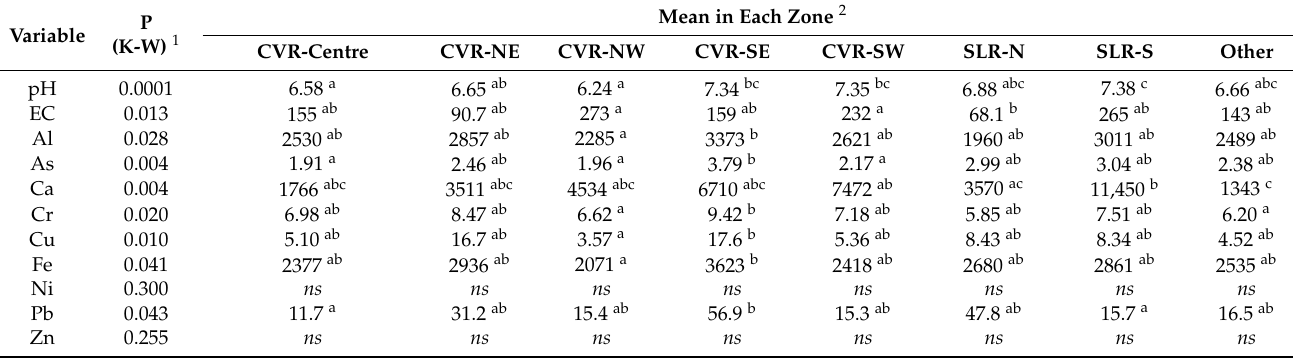
Table 4. Comparison of pH, EC (1:5 soil: water extract), element concentrations, and IPI in distinct Zones of Smith’s Lake (SLR) and Charles Veryard (CVR) Reserves. Mean values in a row are different if no superscript letters are shared ( p ≤ 0.05, Conover’s pairwise test with Holm’s